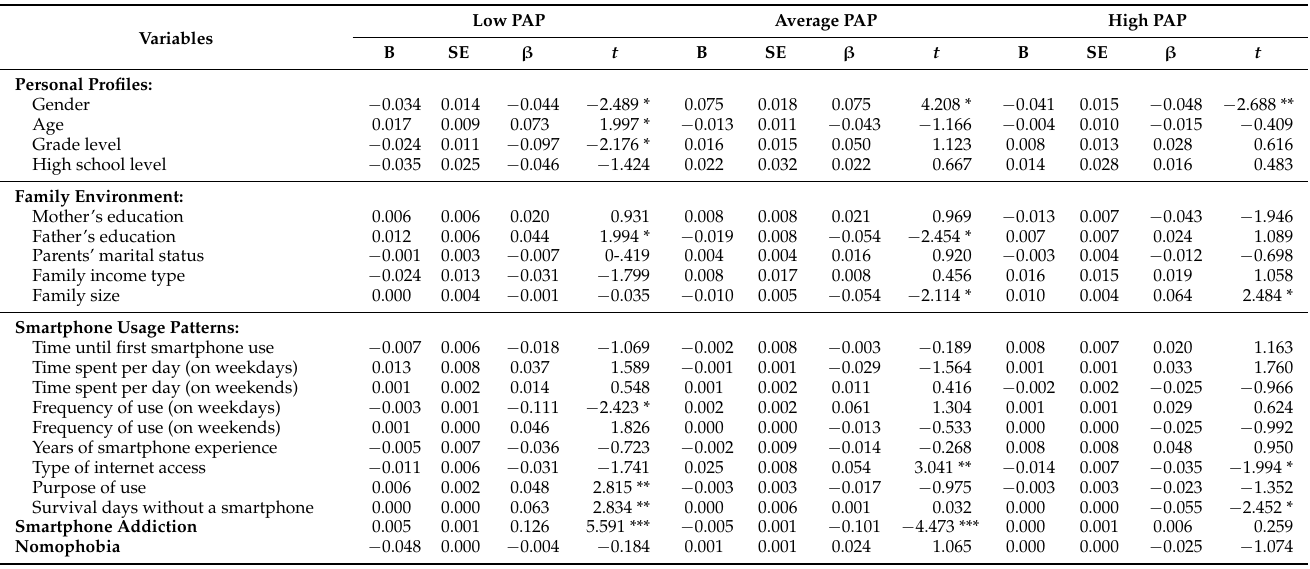
Table 4. Summary of the multiple linear regression analysis of personal profiles, family environment, smartphone usage patterns, smartphone addiction, and nomophobia (predicting low, average, and high perceived academic performance).